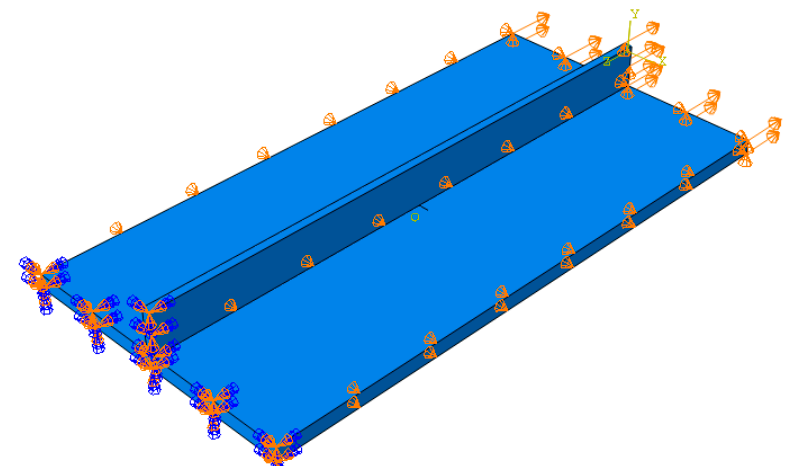
Figure 10. Geometry and boundary conditions of uniaxial tensile model.